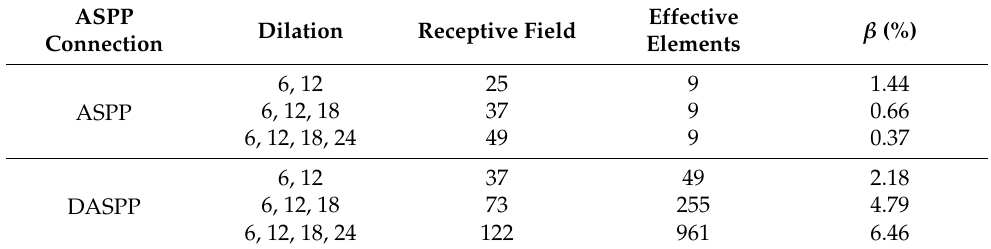
Table 3. Effect of ASPP connection method on the atrous